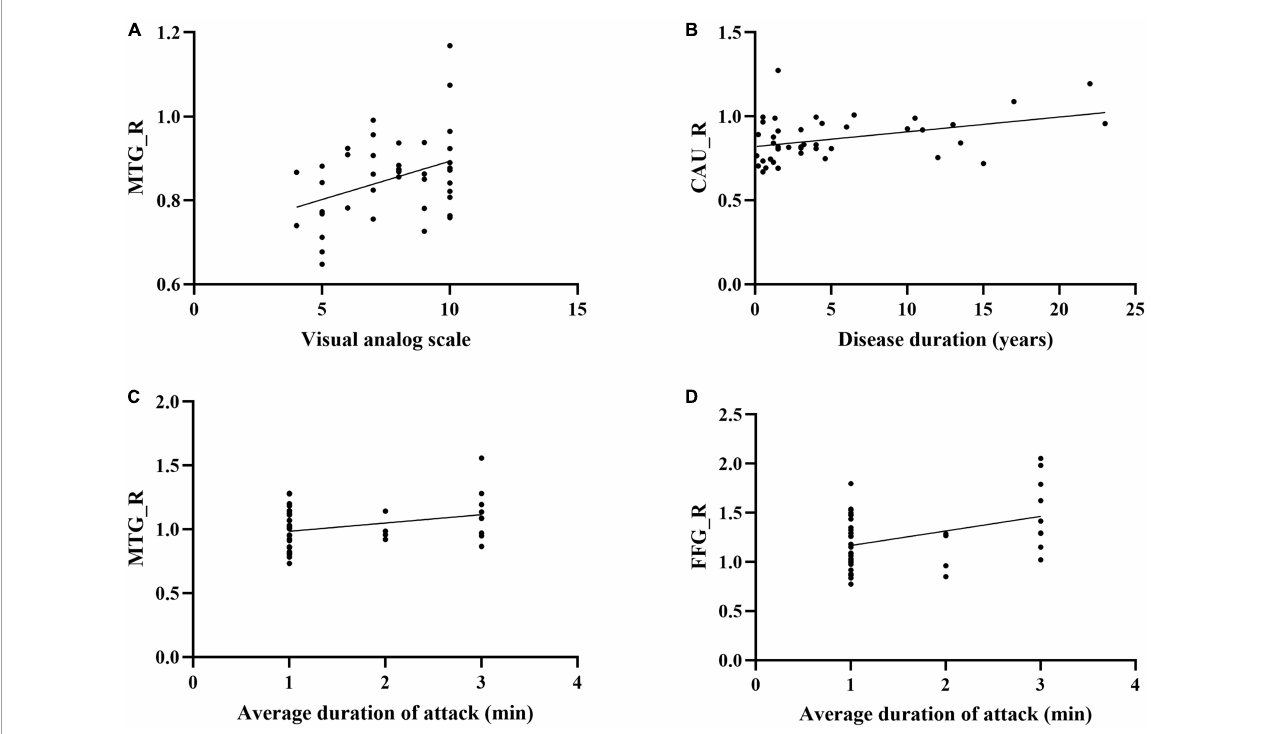
FIGURE5 Correlations between the clinical parameters and brain regions which the sDC were changed in CTN patients. (A) The sDC value of MTG_R was positively correlated with the visual analog scale ( P = 0.013, r = 0.377). (B) The sDC value of CAU_R was positively correlated with the disease duration (years) ( P = 0.010, r = 0.390). (C) The sDC value of MTG_R was positively correlated with the average duration of attack ( P = 0.036, r = 0.321). (D) The sDC value of FFG_R was positively correlated with the average duration of attack ( P = 0.008, r = 0.399). sDC, static degree centrality; CTN, Classical trigeminal neuralgia; Baseline, the rs-fMRI was performed before stimulating the trigger zone; triggering-5 s, the rs-fMRI was performed within 5 s after stimulating the trigger zone; CAU_R, right caudate nucleus; FFG_R, right fusiform gyrus; MTG_R, right middle temporal gyrus.